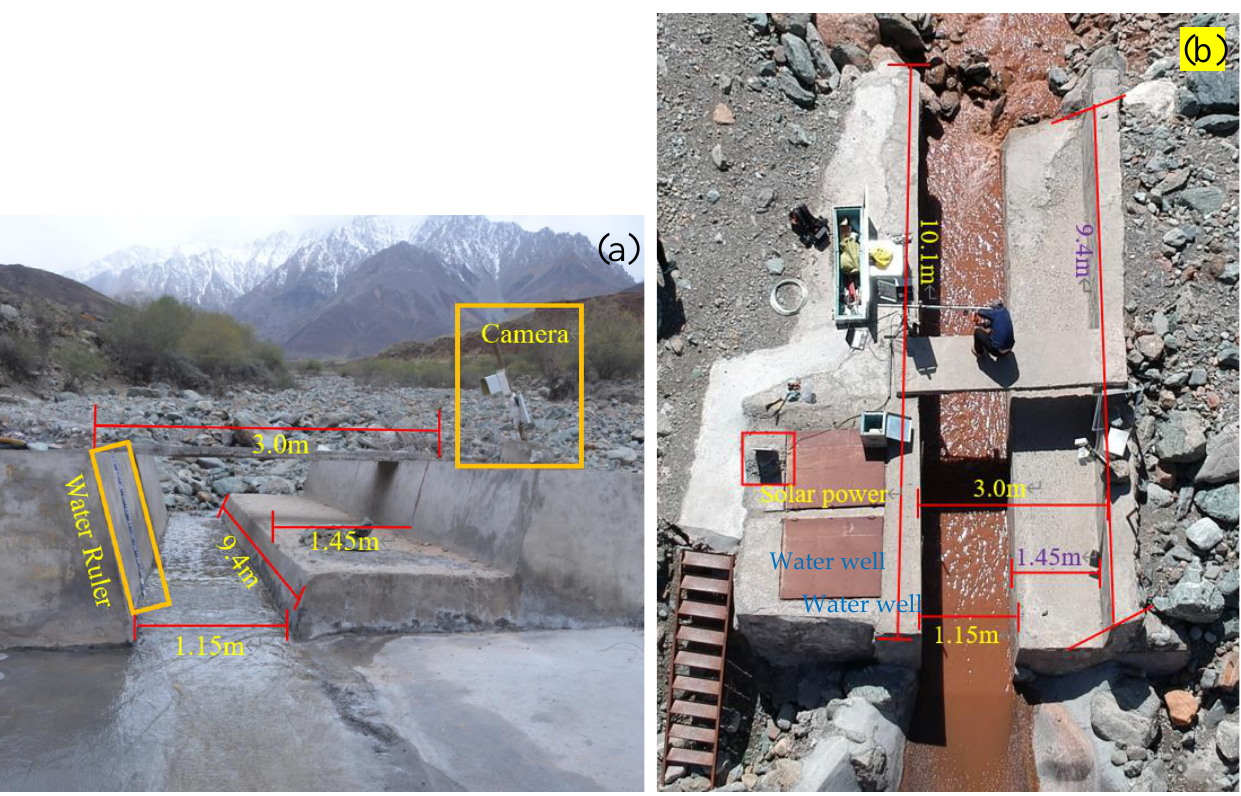
Figure 2. The hydrographic cross-section located in the Hulu watershed of the Qilian Mountains. ( a ) Cross-sectional view. ( b ) Vertical view. The camera in this figure is an infrared sensor camera called LTL5120A, which can automatically shoot continuously according to the set time interval, and the resolution of the photos taken is 2560 × 1920. Earlier the cross-section used automatic water level logger to measure water level, which has some drawbacks, such as